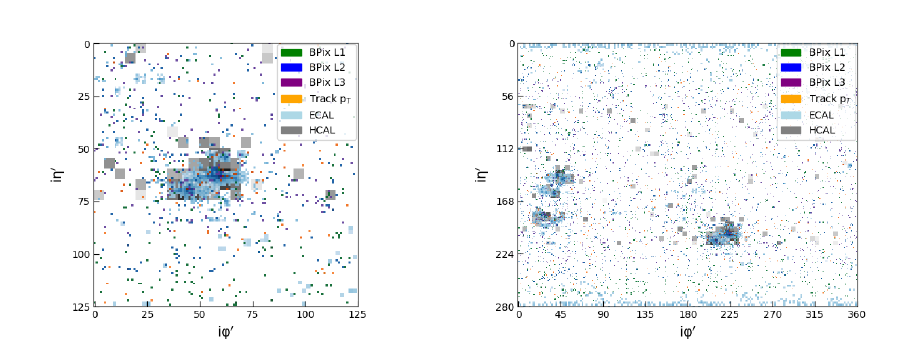
Figure 1. Composite image of a simulated boosted top quark jet (left). Image is constructed at the ECAL